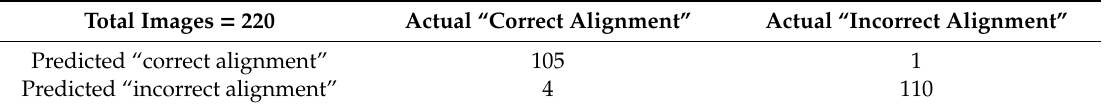
Table 1. Confusion matrix for test dataset.